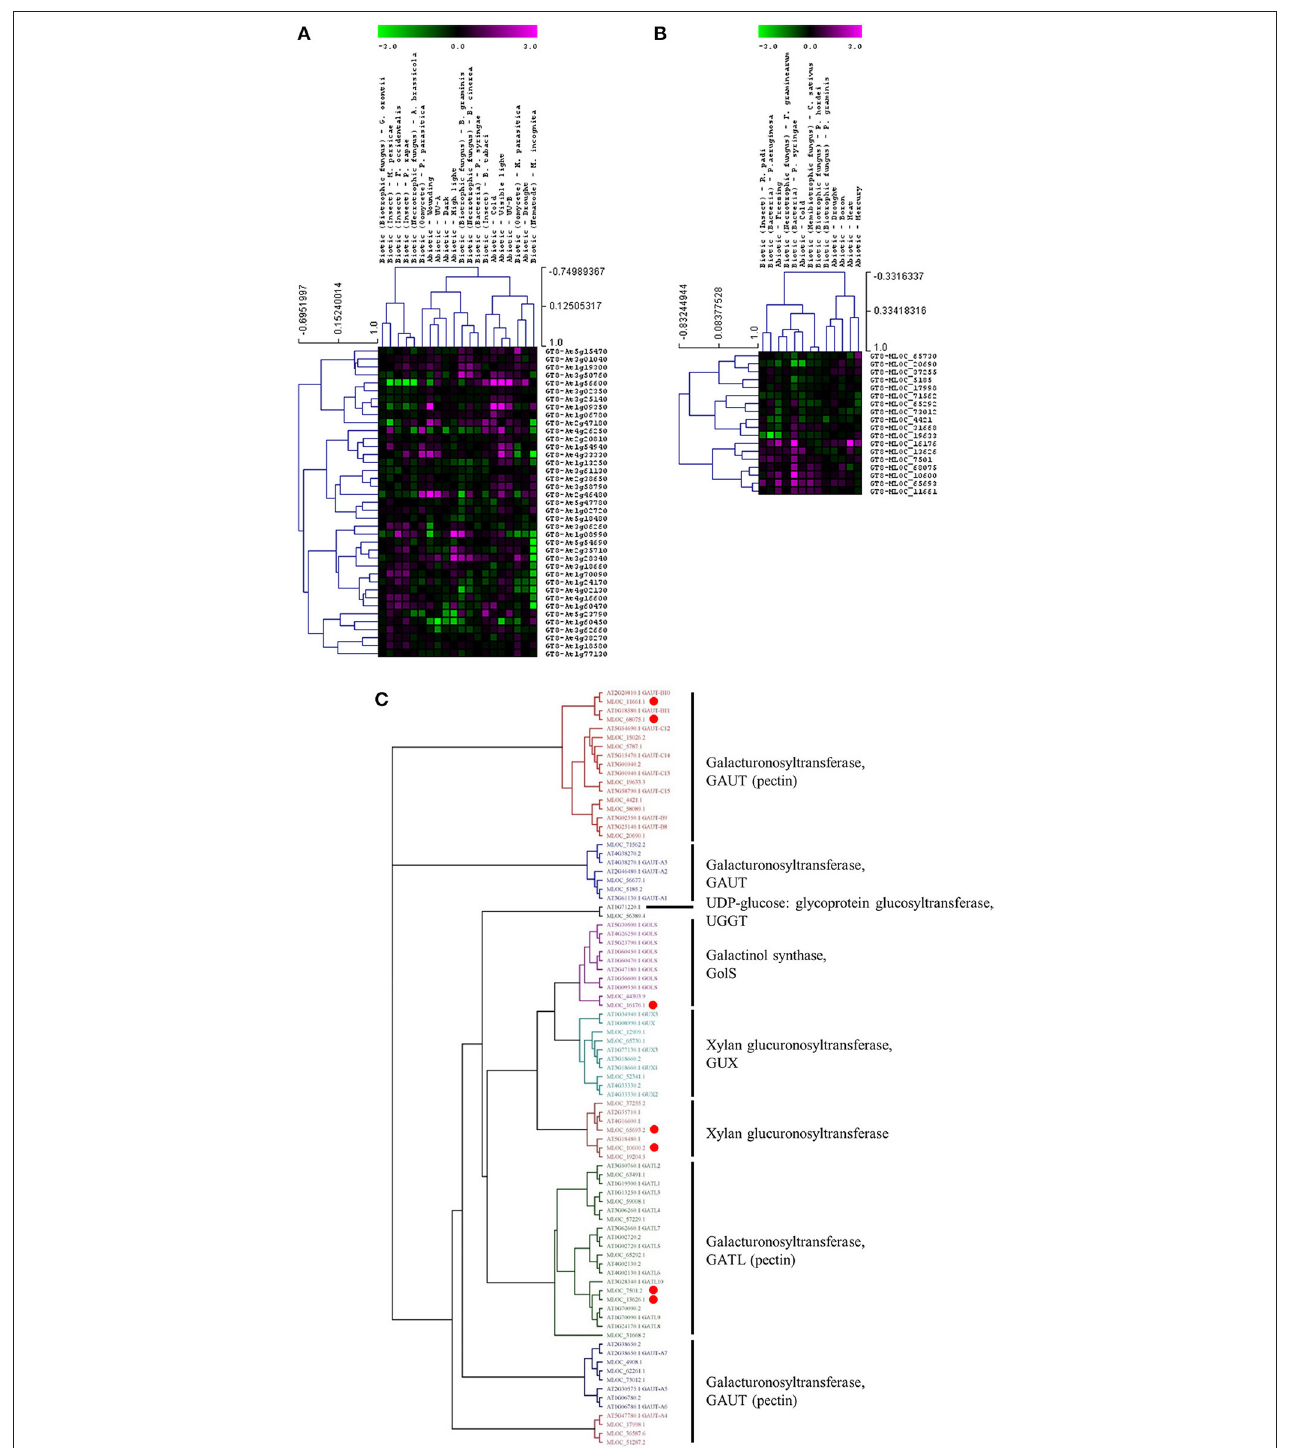
FIGURE 3 | Analysis of GT8 family members following abiotic and biotic stresses in Arabidopsis (A) and barley (B). Transcript abundance was determined through meta-analysis of microarray datasets collected from the Plant Expression Database (PLEXdb; Dash et al., 2012) using the experiments listed in Table 2 . Values show the average log(2)-fold induction for representatives of each CAZy gene family present on the Arabidopsis Affymetrix 22K ATH1 genome array and the 22K Barley1 genechip. Hierarchical clustering was performed based on the Pearson correlation coefficients across each dataset and CAZy family. (C) Phylogenetic tree of GT8 family members from Arabidopsis and barley with putative functions assigned for each clade. Red dots highlight barley genes that are upregulated in response to stress (B) .